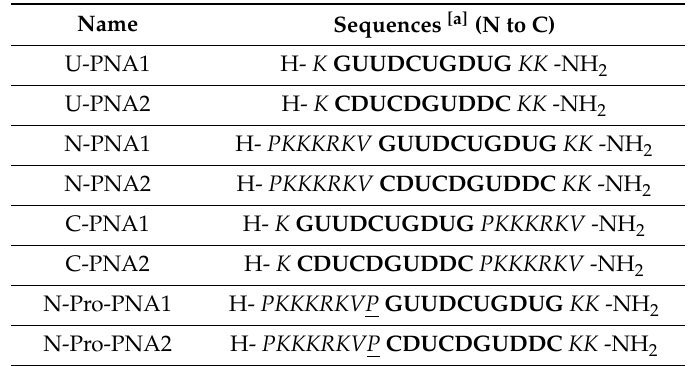
Table 1. PNAs synthesised and used in this